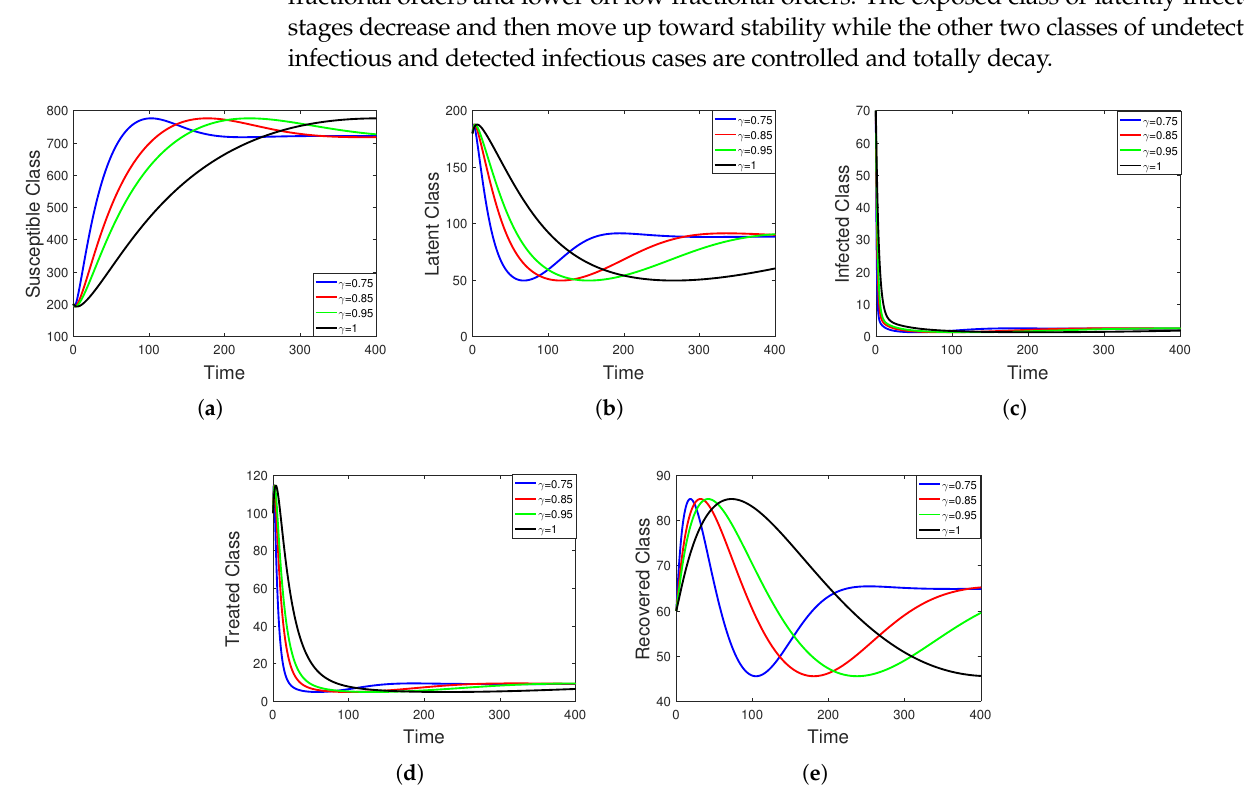
Figure 1. A graphic view of all five compartments ( a – e ) of human society for different arbitrary orders γ = 0.75, 0.85, 0.95, 1 for initial data and time